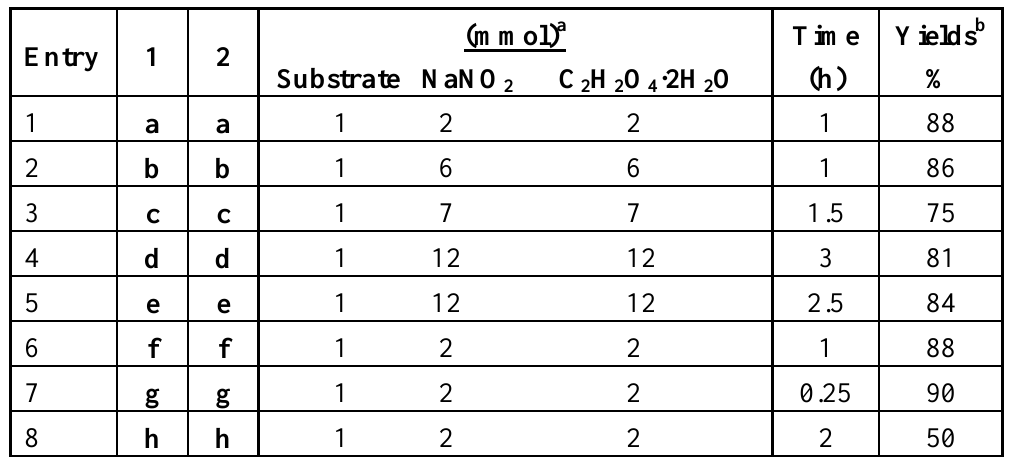
Table 1. Nitrosation of β -Diketones